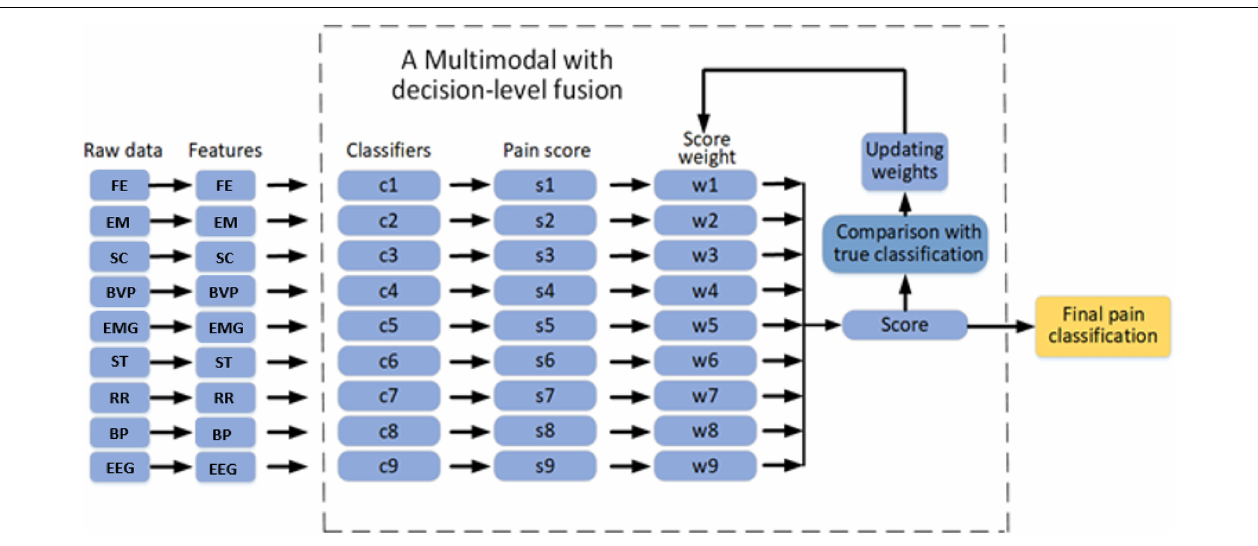
FIGURE 13 | The flowchart of our decision-level multi-modal fusion [facial images (FE), electroencephalography (EEG), eye movement (EM), skin conductance (SC), and blood volume pulse (BVP), electromyography, respiration rate (RR), skin temperature (ST), and blood pressure (BP)].